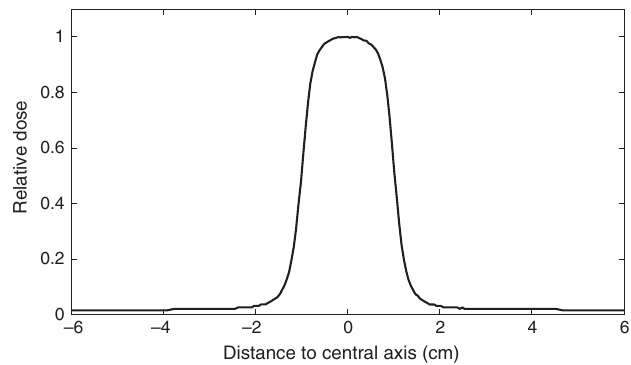
FIG. 5. Relative dose profile of the field 2 (cid:1) 2 cm 2 given by the TPS [5].